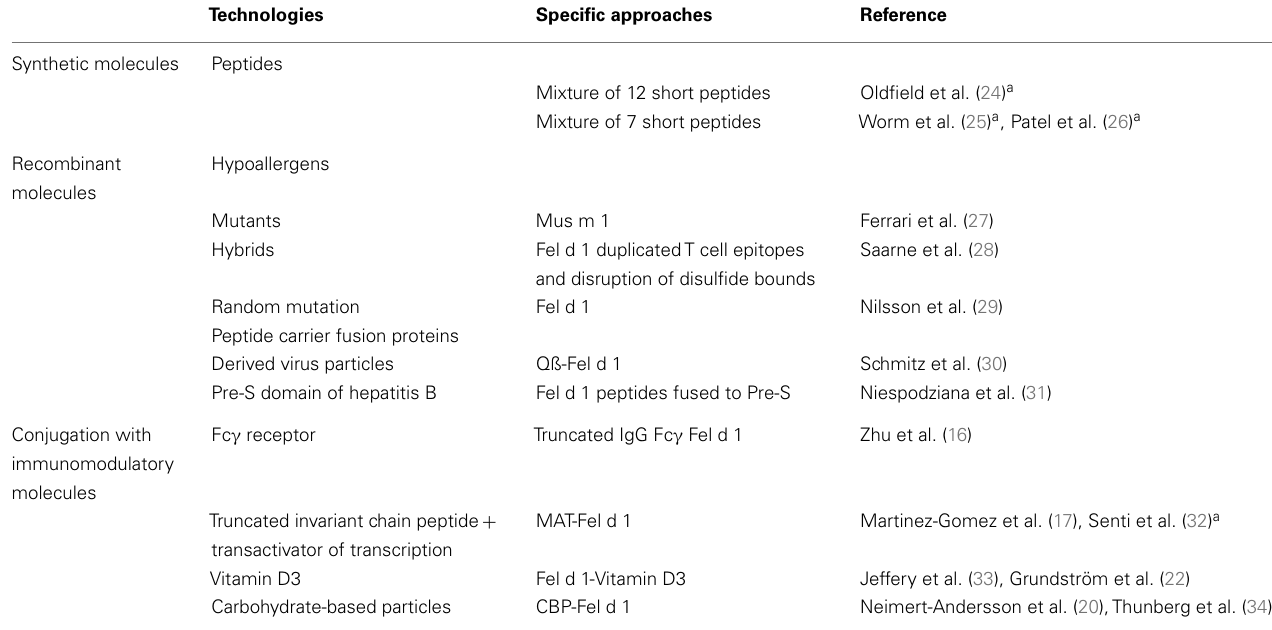
Table 1 | Concepts and strategies for improving SIT for mammalian allergy